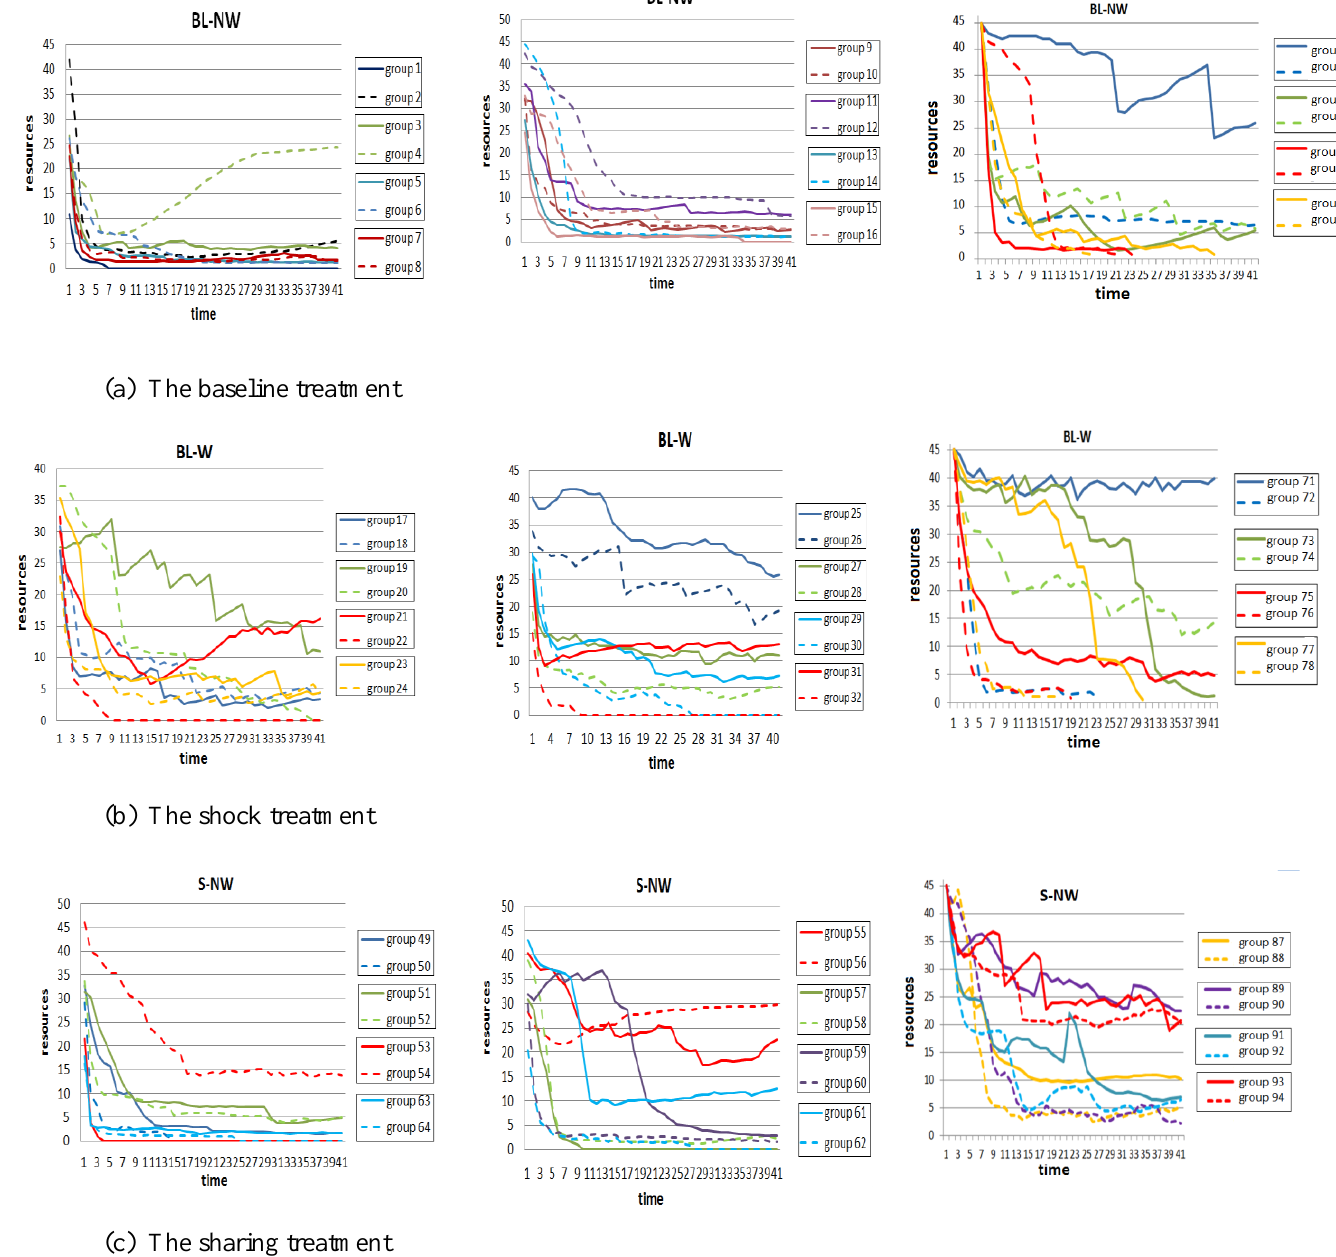
Figure B1.1 Availability of resources at a given period. Boxes indicate interacting groups, i.e. partners. To increase visibility we depict 4 partner groups per figure. Figures on the right show results from the sample of subjects from the University of